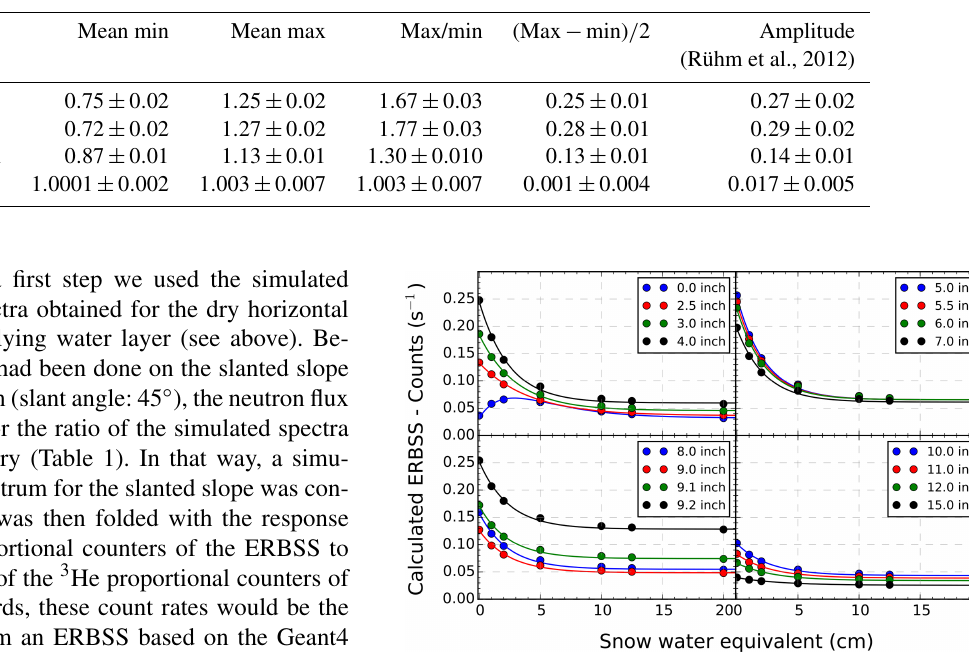
Table 2. Normalized mean minimum (for January–March and December 2018) and maximum (for July–October 2018) neutron flux values (including standard deviation) taken from Fig. 5, the difference of these values divided by 2, and corresponding data taken from Rühm et al. (2012).